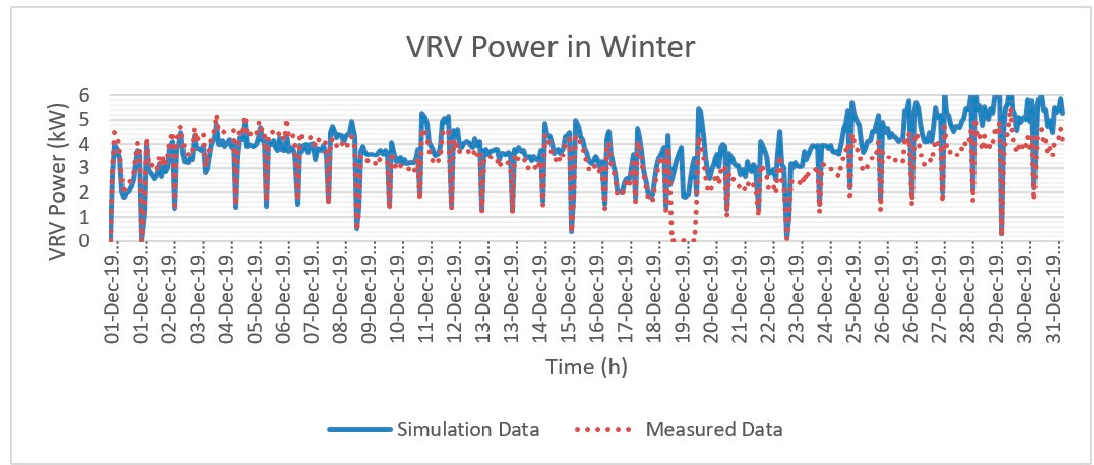
Figure 7. The measured and simulated power consumption in summer.